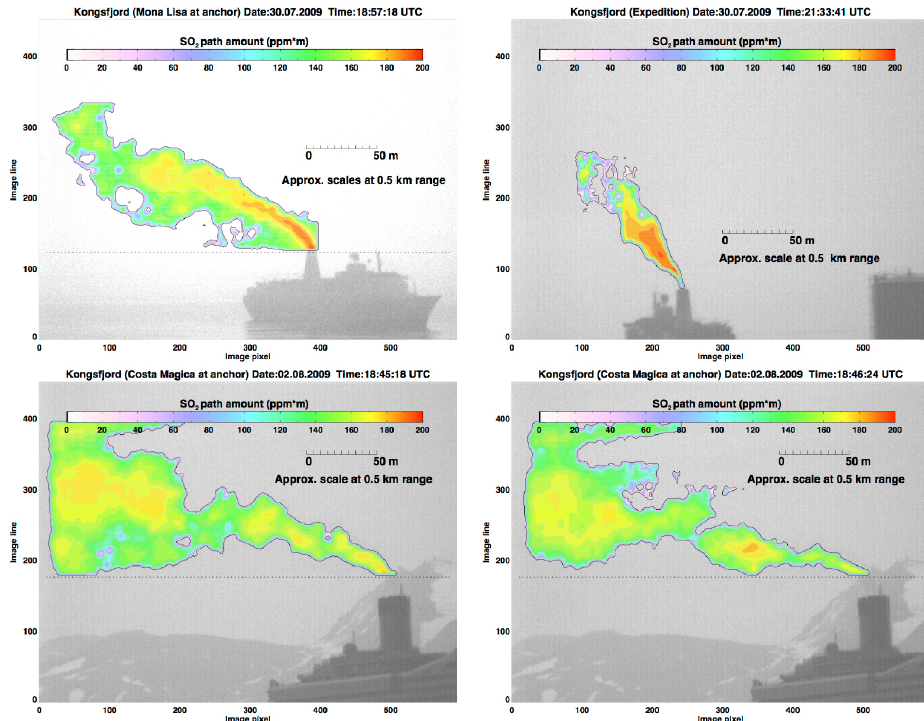
Fig. 8. SO 2 path amounts retrieved from the UV camera for three different vessels in Kongsfjord at anchor or slowly manoeuvering.